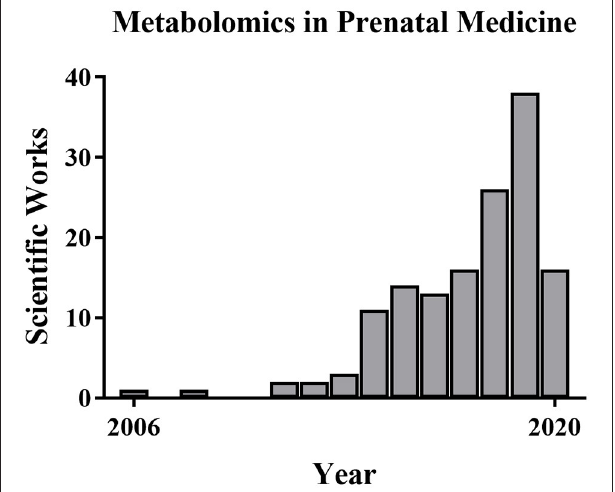
FIGURE 3 | Metabolomics publications in prenatal medicine. The number of metabolomics publications in prenatal medicine is low but increased from 2006 to 2019 based on PubMed